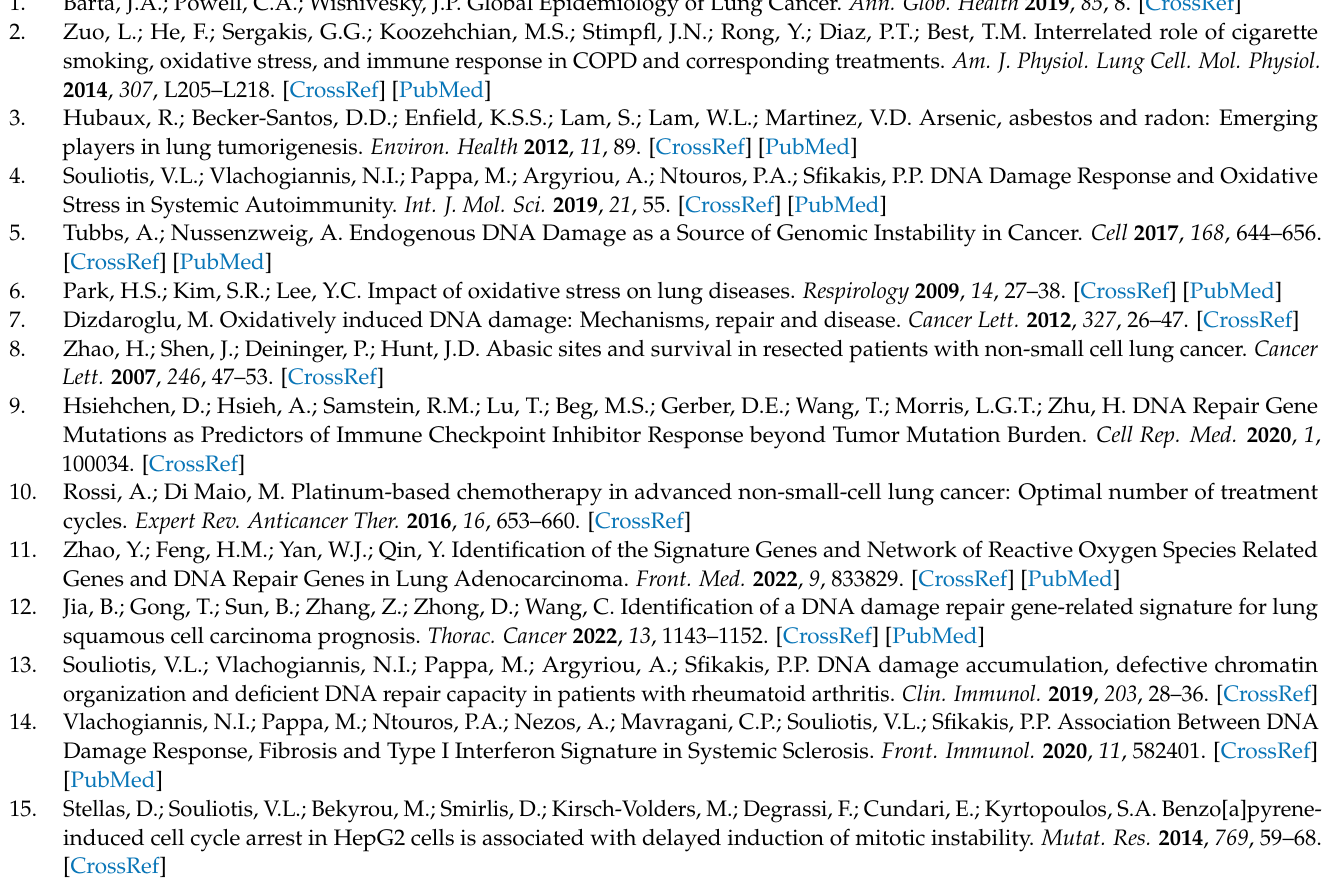
Figure S1. ATM signaling pathway; Figure S2. Role of BRCA1 in DNA damage response; Figure S3. Base Excision Repair Pathway; Figure S4. Role of CHK proteins in cell cycle checkpoint control; Figure S5. Cell cycle: G2/M DNA damage checkpoint regulation; Figure S6. DNA double-strand break repair by non-homologous end joining; Figure S7. Cyclins and cell cycle regulation; Figure S8. p53 signaling; Figure S9. Color and shape legends are useful for IPA ® pathway/network